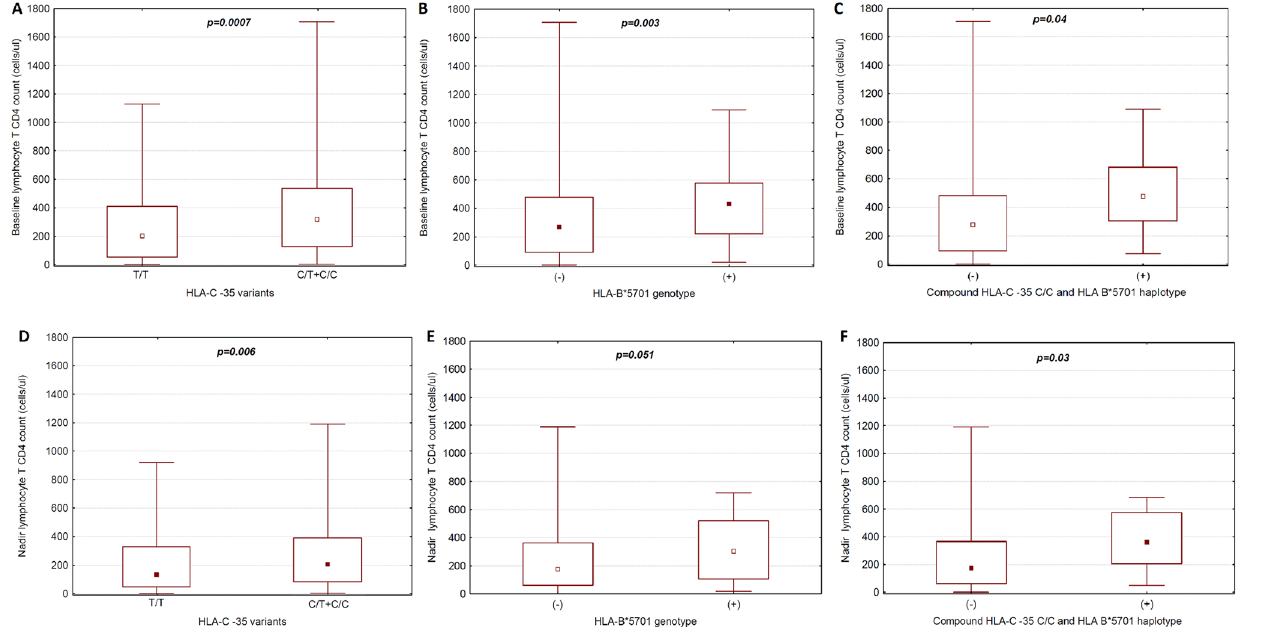
Fig 2. Box-whisker plot of the relationship between baseline lymphocyte CD 4 cell count and (a) HLA-C locus -35 genotypes for T/T homozygotes vs. C allele carriers (C/T+C/C), (b) HLA B * 5701 genotype, (c) compound HLA-C locus -35 C/C and HLA B * 5701 haplotype as well as nadir lymphocyte CD 4 cell count and (d) HLA-C locus -35 genotypes for T/T homozygotes vs. C allele carriers (C/T+C/C), (e) HLA B * 5701 (+) genotype, (f) compound HLA-C locus -35 C/C and HLA B * 5701(+) haplotype. Boxes are IQR. Whiskers are CD4 count ranges. Central square inside a box represents a median. For statistics U-Mann-Whitney test was